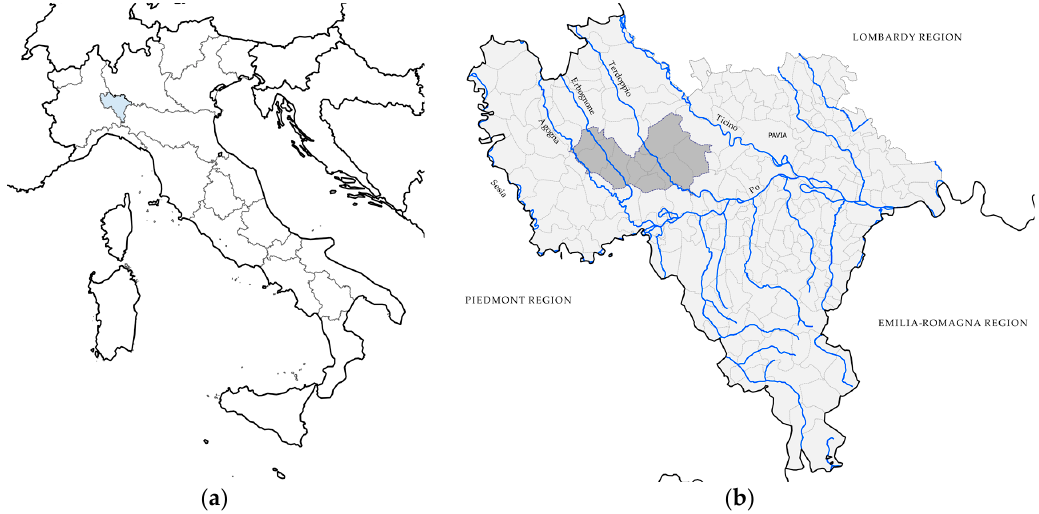
Figure 1. Location of the study area: ( a ) Pavia province, Lombardy region; ( b ) the study area.